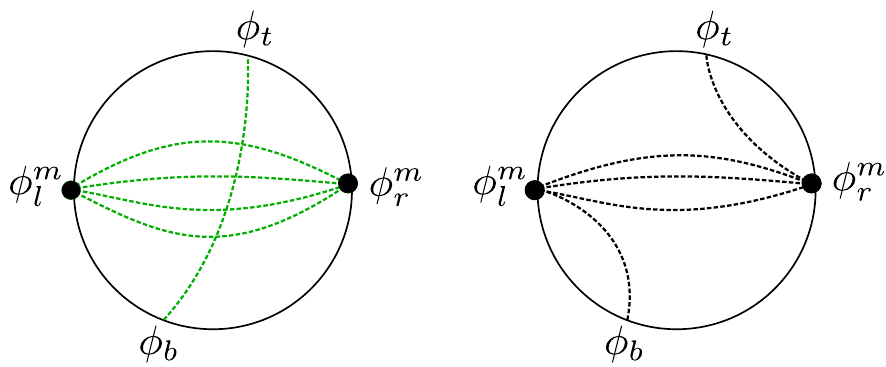
(cid:30) ( u t ) (cid:30) m (cid:30) m (cid:30) ( u b ) in (G.1). r j l h j i